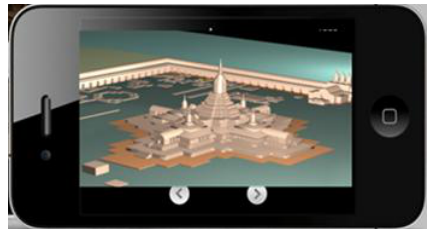
Fig 6: Information regarding the lost Monument can be disseminated through the smart phone